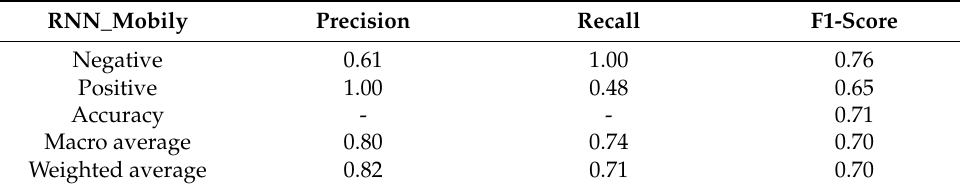
Table 7. Confusion matrix obtained by RNN on the Mobily dataset.